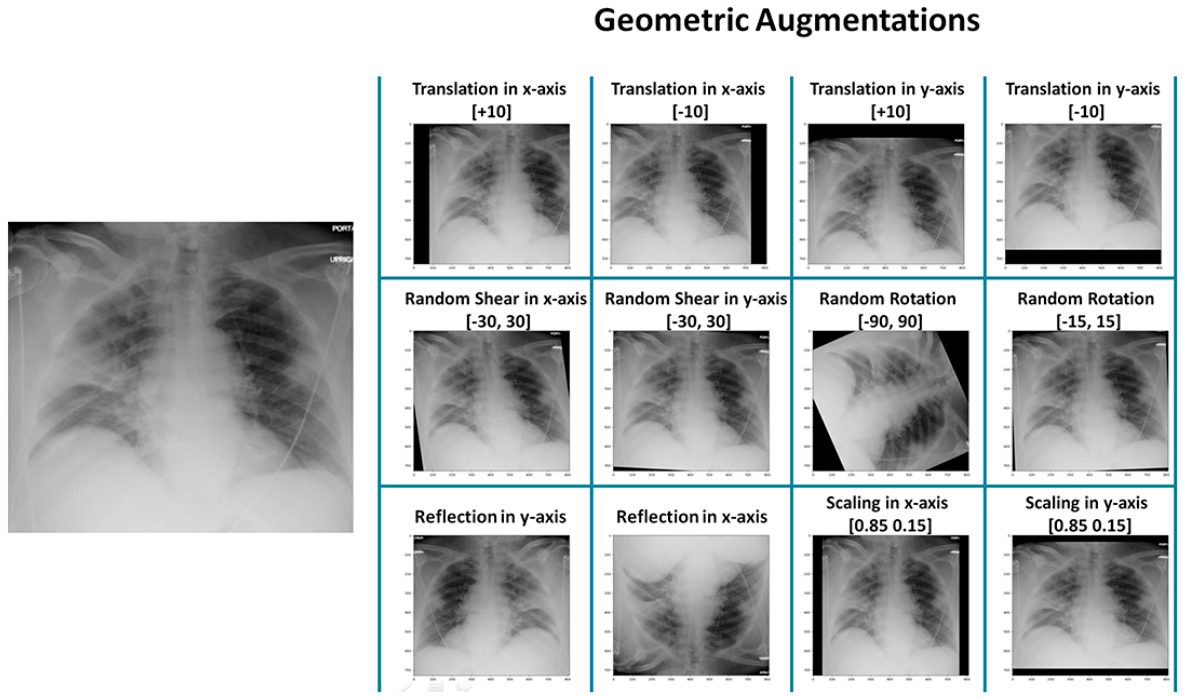
Figure 5. Some examples of data augmentation techniques to balance the classes.